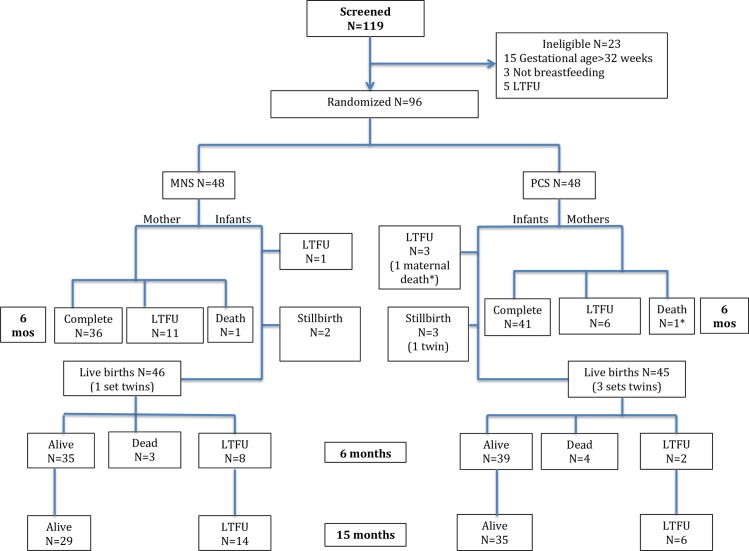
Consort diagram.